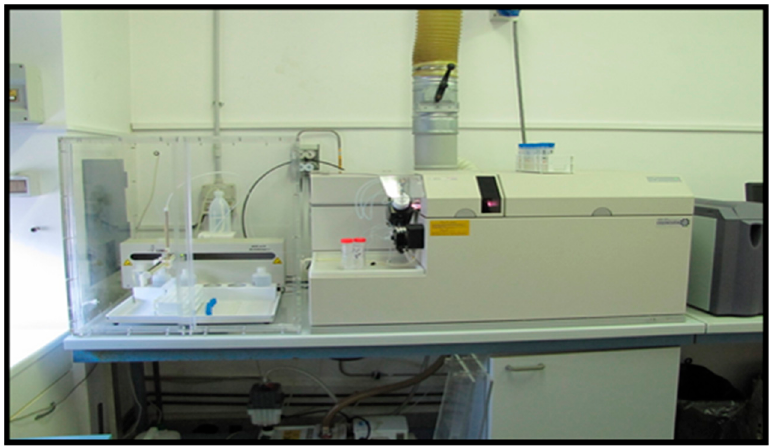
Figure 3. Agilent 7500ce inductively coupled plasma-mass spectrometer (ICP-MS) at INGV, Palermo .